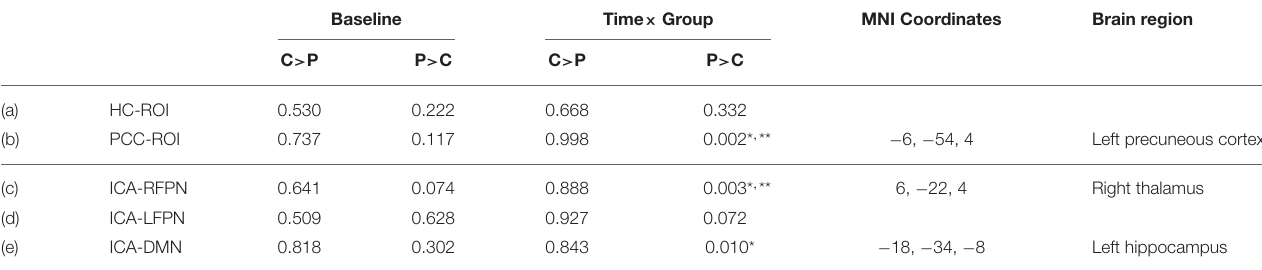
TABLE 4 | Minimal family-wise error corrected p -value of the investigated rsfMRI networks for carnosine/anserine (C) group compared against placebo (P)